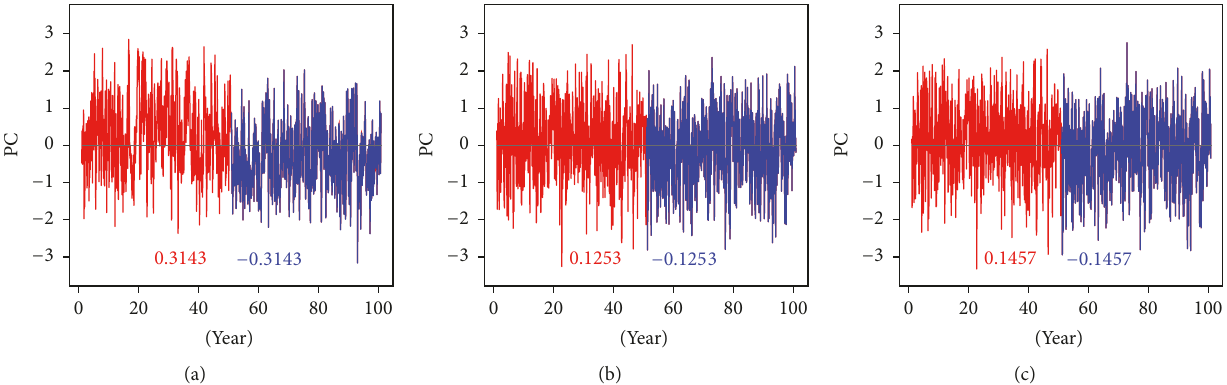
Figure 7: PC time series corresponding to the first EOFs of geopotential height at the three model levels: upper level (a), middle level (b), and lower level (c). The numbers display the mean of the corresponding PC series for the 50-year-long time series. Red and blue colors correspond to the model runs with high and low Arctic sea-ice-cover conditions,